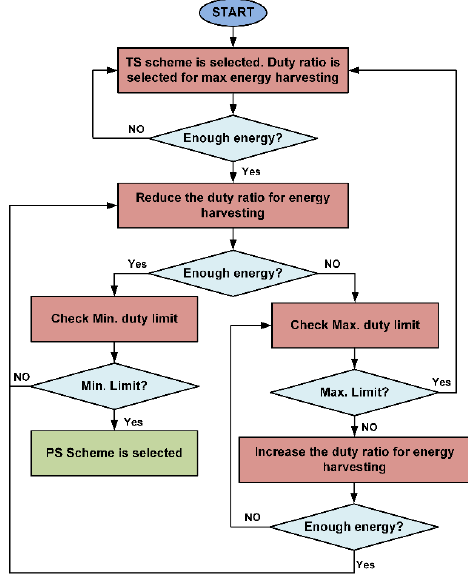
Sensors 2021 , 21 , x FOR PEER REVIEW Figure 7. Flow diagram for the SWIPT transmitter during the TS scheme. Figure 7. Flow diagram for the SWIPT transmitter during the TS scheme.